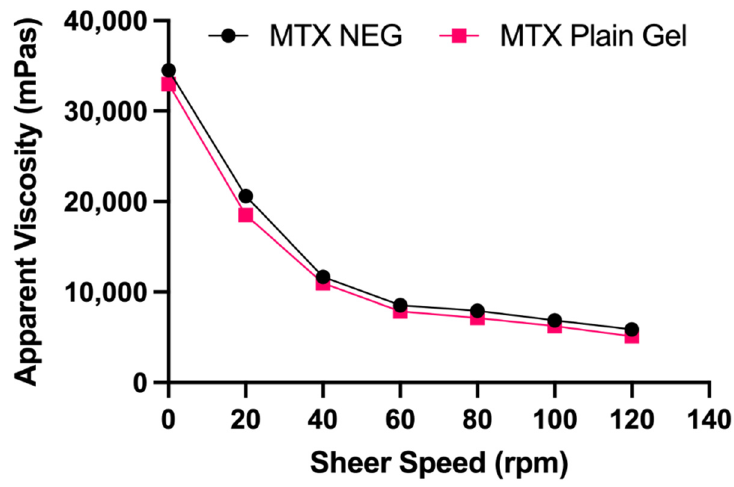
Figure 1. Flow curves of MTX NEG and MTX plain gel. Data are expressed as mean ± SD ( n = 3).